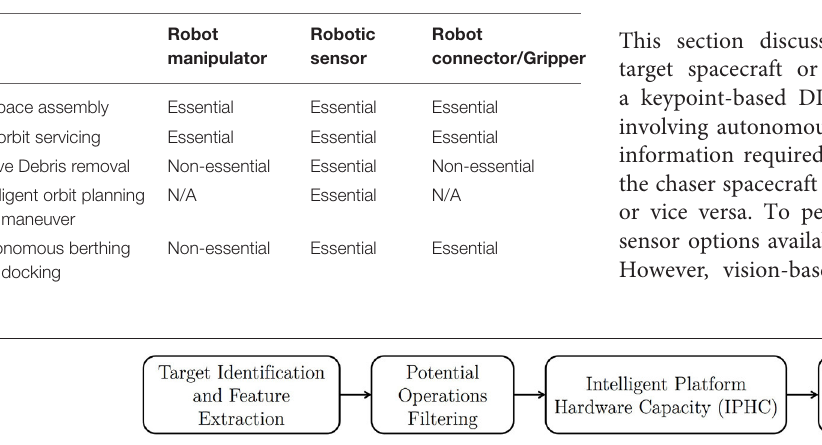
TABLE 1 | Intelligent Platform Hardware Capacity (IPHC) links the combination of robotic hardware with the potential type of missions.